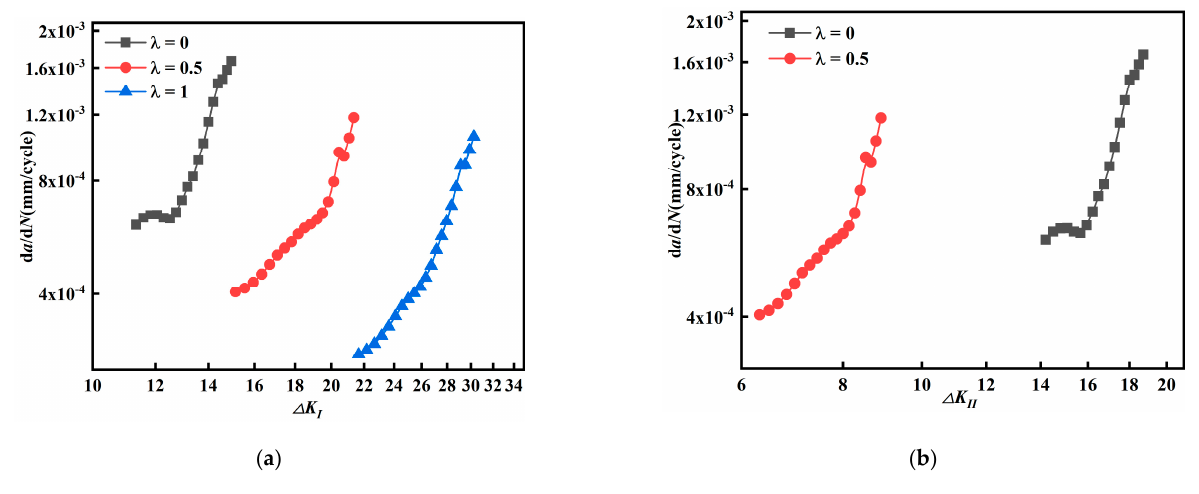
Figure 11. Relationship between stress intensity factor amplitude △ K I , △ K II , and da/dN ( β =45°). ( a ) Relationship between △ K I and da/dN . ( b ) Relationship between △ K II and da/dN .